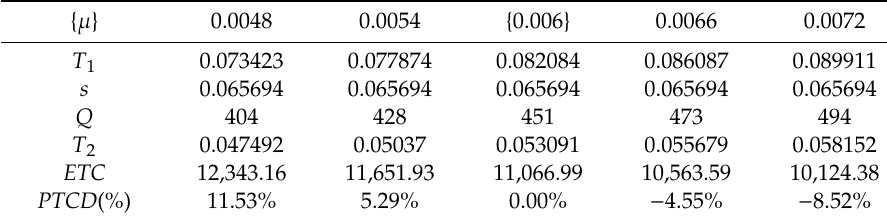
Table 7. Sensitivity analysis when the arrival rate changes.